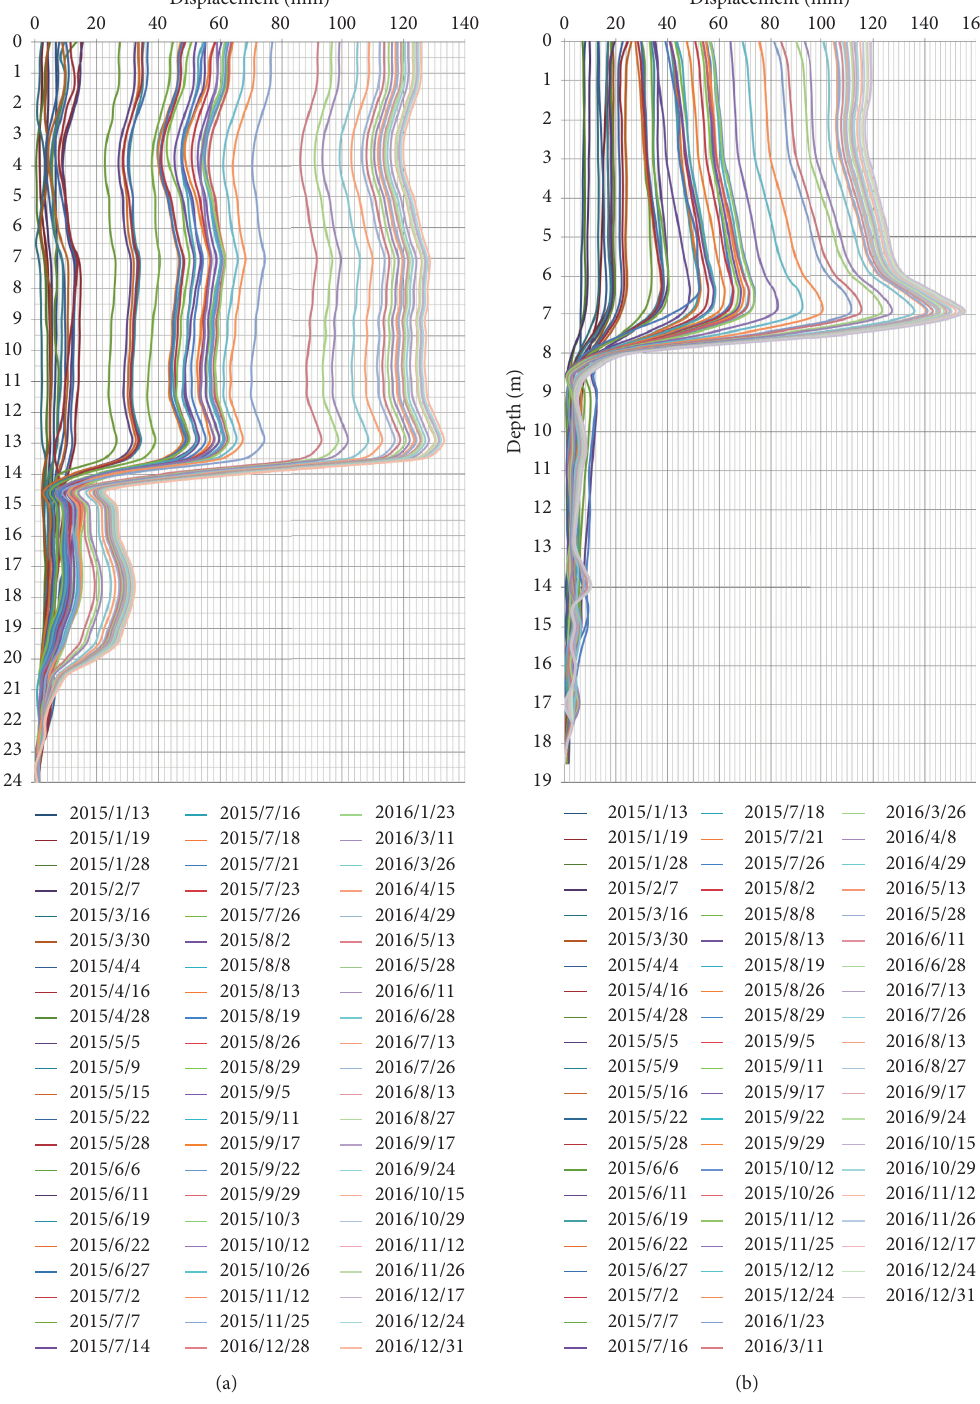
Figure 6: (a) 1AJC09 cumulative total displacement curve. (b) 1AJC12 cumulative total displacement